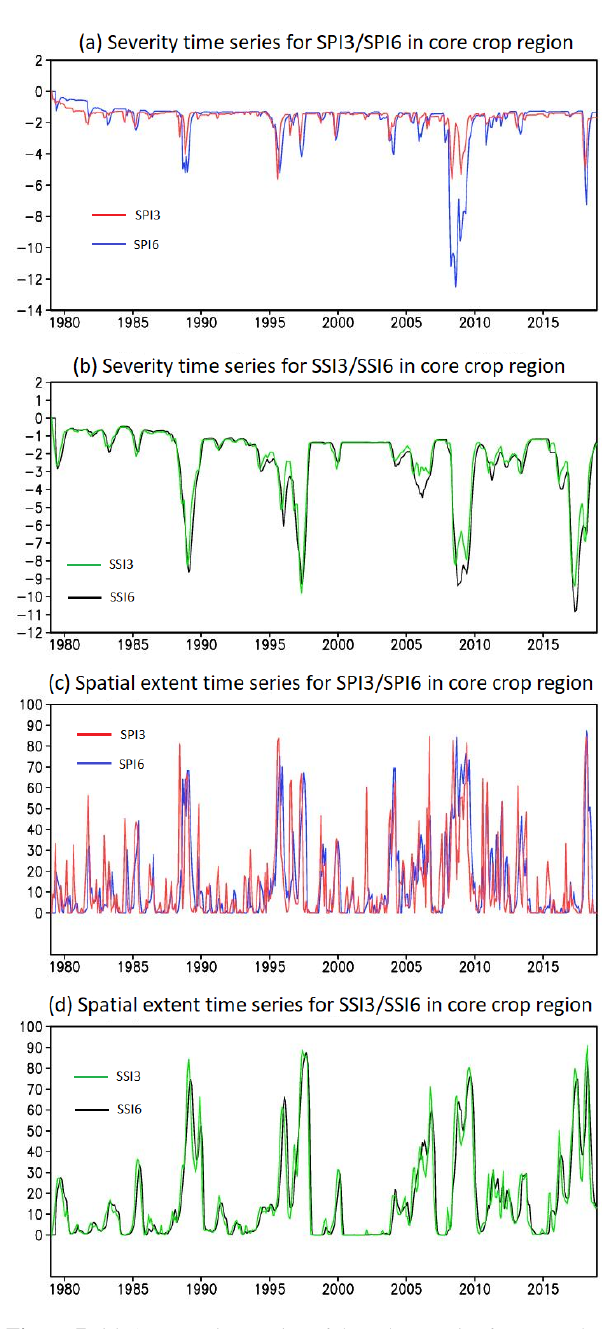
Figure 7. (a) Average time series of drought severity for events be- low X 2 in the core crop region based on SPI3 and SPI6 indices. (b) As in panel (a) but for SSI3 and SSI6. (c) Average time series of the droughts’ spatial extent for events below X 2 as a percentage of the core crop region’s total area, based on SPI3 and SPI6 indices. (d) As in panel (c) but for SSI3 and SSI6. All computations were done from January 1979 to December 2018.